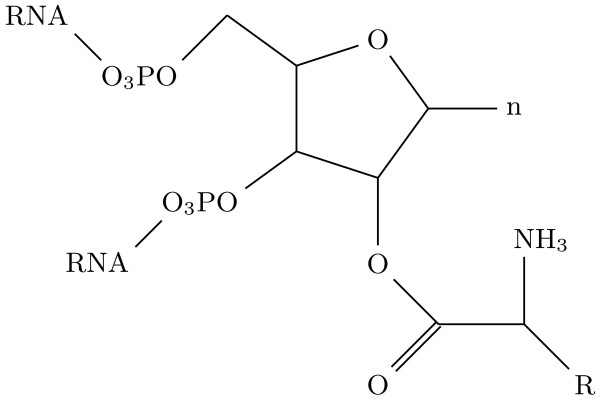
Attachment of an amino acid to a ribose in an RNA. One possible way of attaching the amino acid is a ester bond between its carboxyl group and the ribose's 2'C. R represents the side chain of the amino acid, and n the nucleoside.